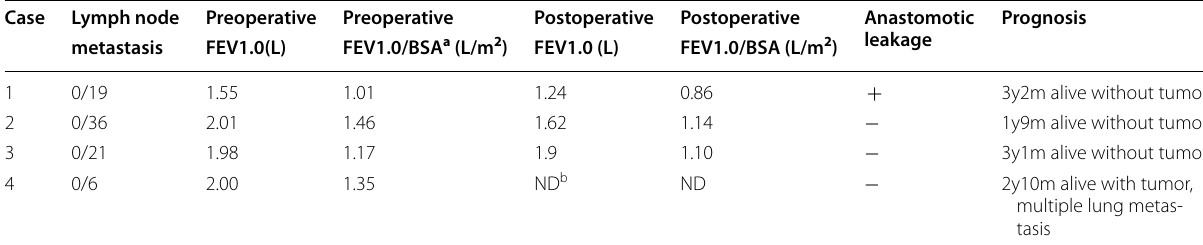
Table 2 Pre- and post-pulmonary functions and clinical